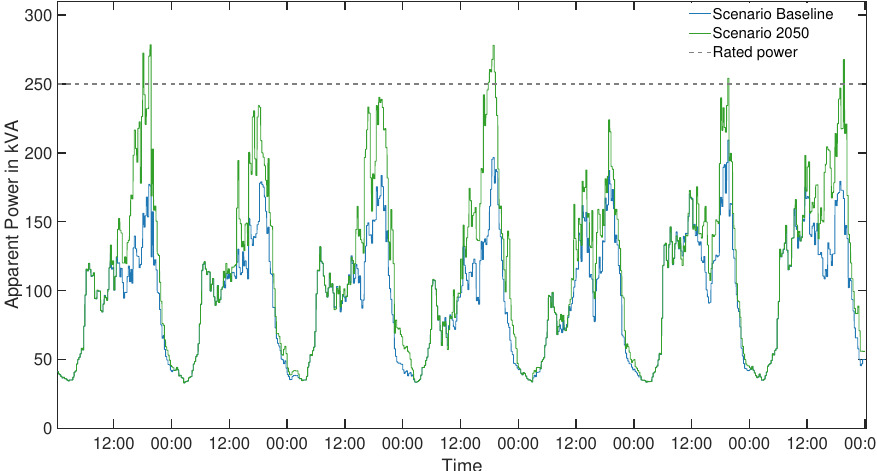
Figure 4. Comparison of voltage and current violations duration for different EV penetration rates between the summer and winter week for the heavy load case.